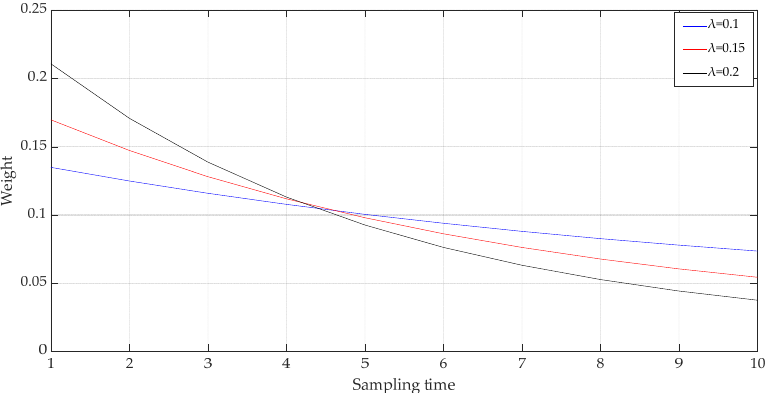
Figure 1. Weight distribution of each IMU data sample in a time window (N = 10).